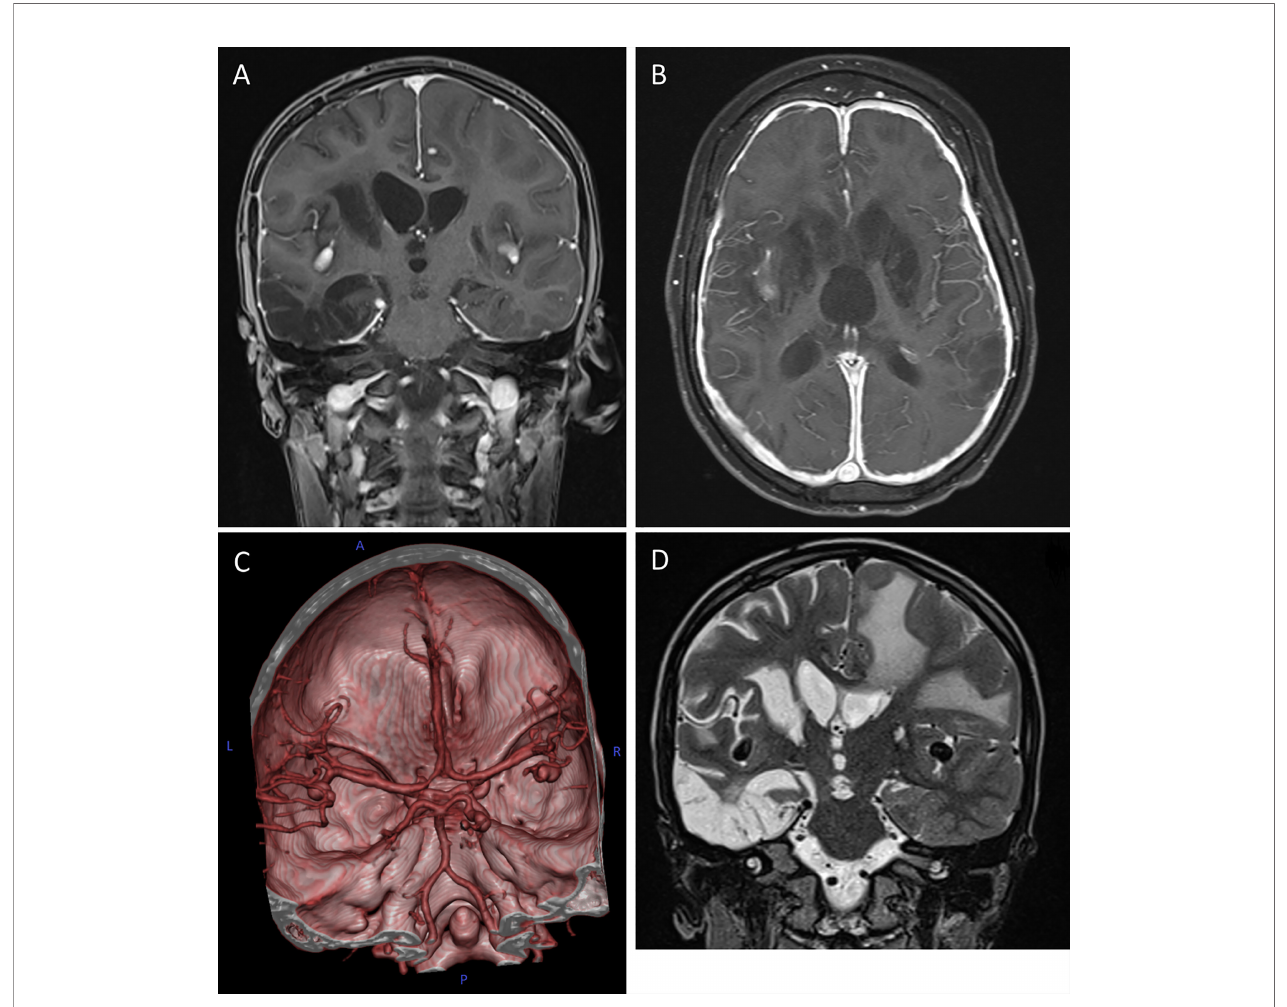
FIGURE 2 | Cerebral magnetic resonance imaging (cMRI) of the index patient at age 10. (A, B) T1-weighted, contrast enhanced MRI scans in coronal (A) and axial (B) plane depicting the hypertrophic pachymeningitis with bilateral basal ganglia, midbrain and cortical lesions. Note the postinfectious internal hydrocephalus. (C) 3D reconstitution of the vascular system of the brain showing bilateral media aneurysms and a posterior cerebral artery aneurysm on the right without signs of vessel narrowing. (D) T2-weighted MRI scan in coronal plane highlighting the extensive frontotemporal white matter edema on the left, global parenchymal atrophy and the medial cerebral artery aneurysms